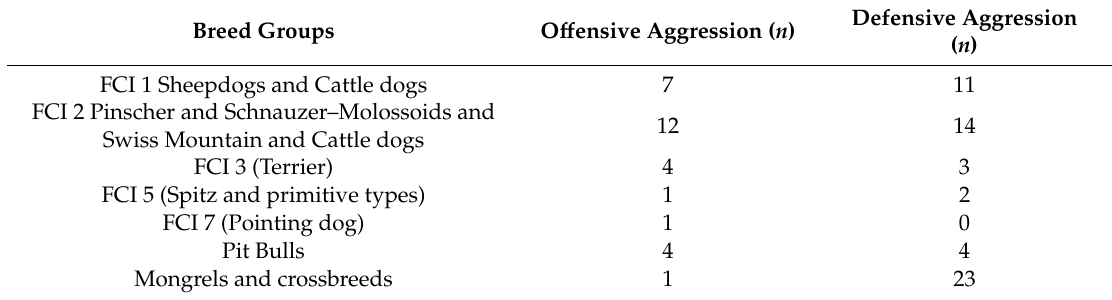
Table 13. Comparison of the type of dog–human aggression in di ff erent breed groups.